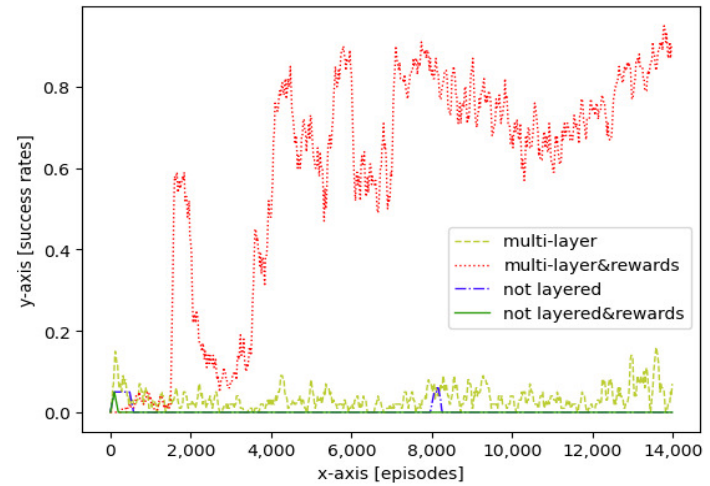
Figure 10. Training success rates, without considering arrival time: multi layer approach without reward shaping; multi layer approach with reward shaping; not layered approach without reward shaping and not layered approach with reward